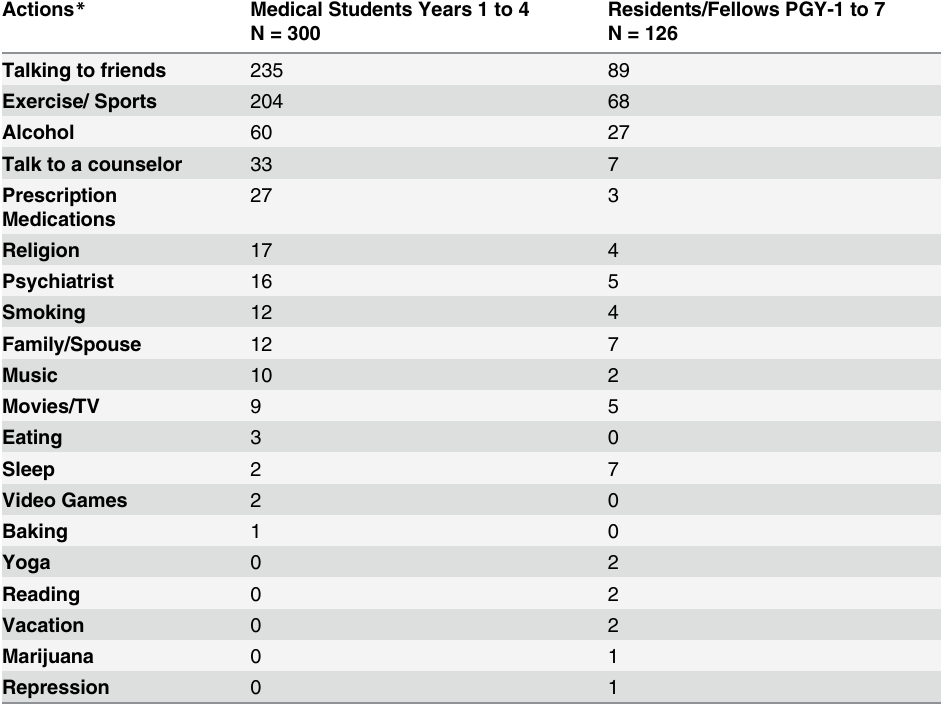
Table 2. Dealing with stress, anxiety, emotions,